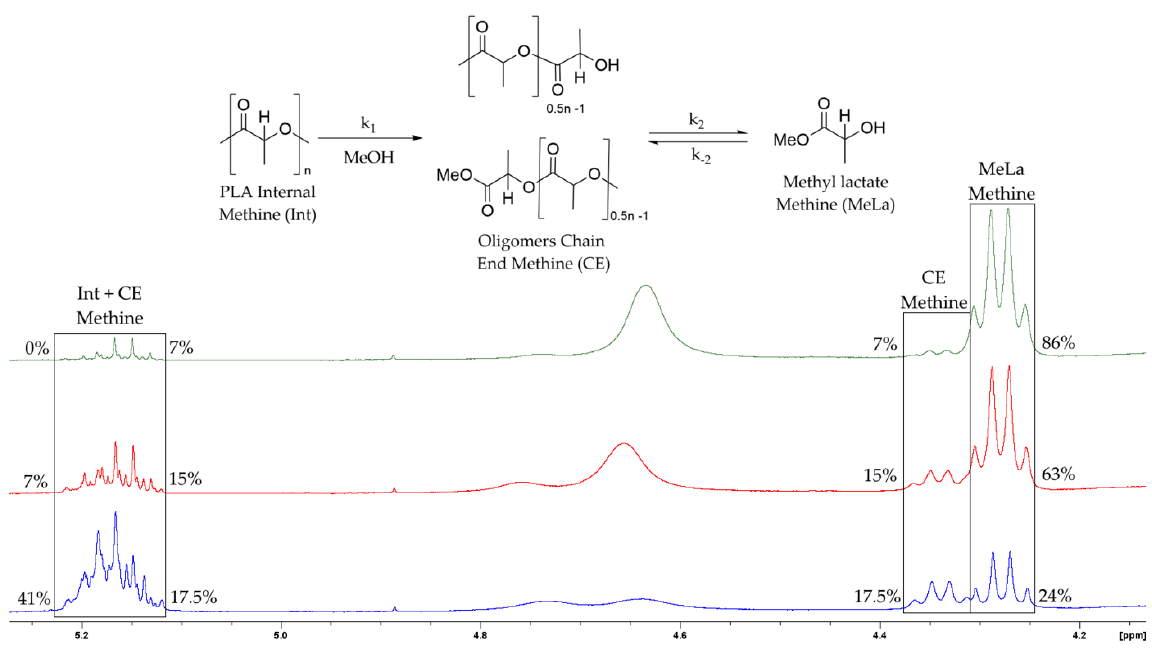
Figure 3. 1 H NMR (CDCl 3 , 400 MHz) stacked spectra of a methanolysis reaction at 120 °C and the relative percentage of each methine proton Int, CE and MeLa. (Blue spectrum 10 min, Red spectrum 40 min, Green spectrum 90 min).